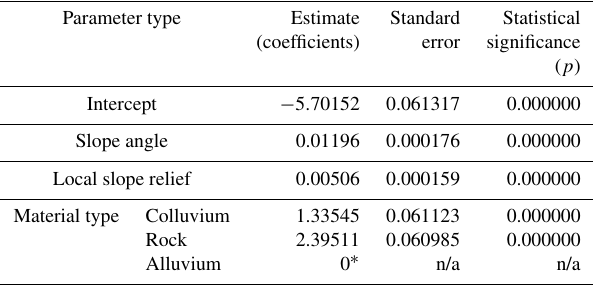
Table B2. Summary table of coefficient estimates for the variables used in the Franz Josef study area logistic regression